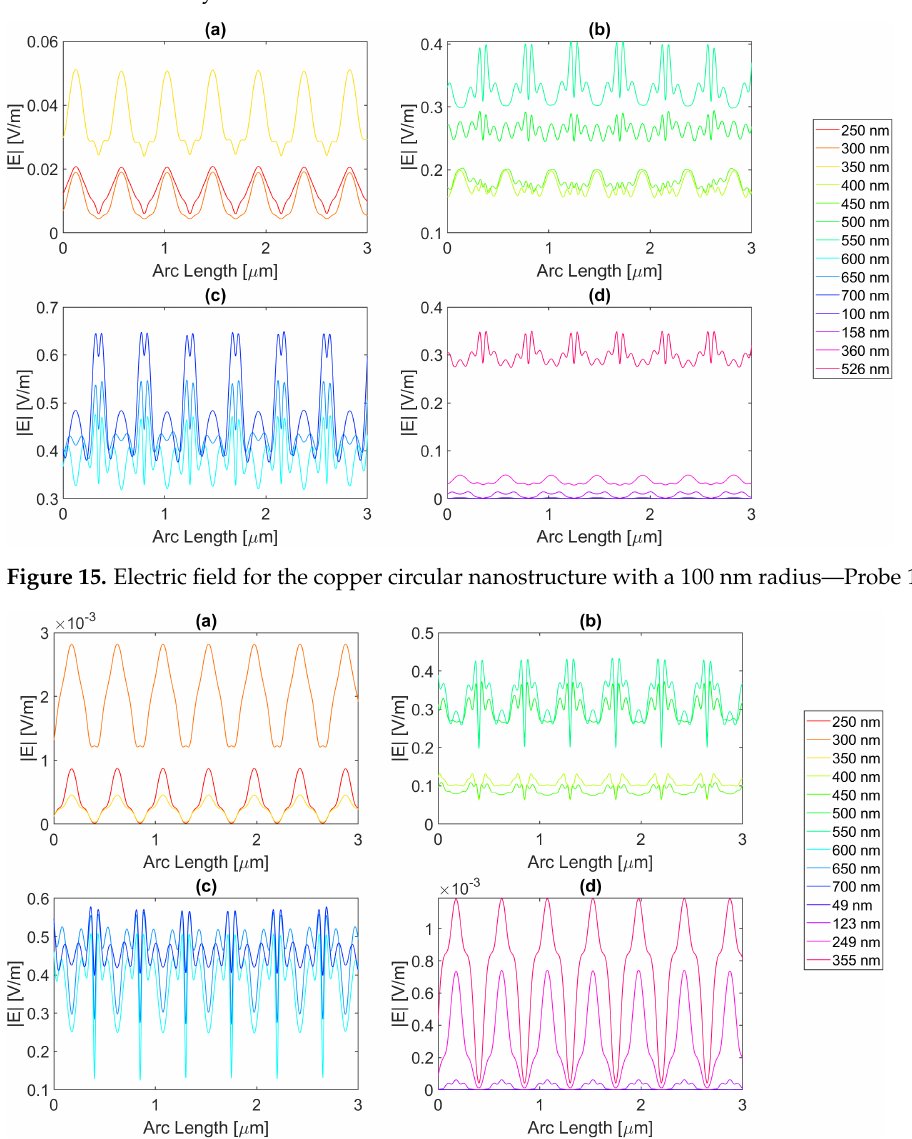
Figure 16. Electric field for the silver circular nanostructure with a 200 nm radius—Probe